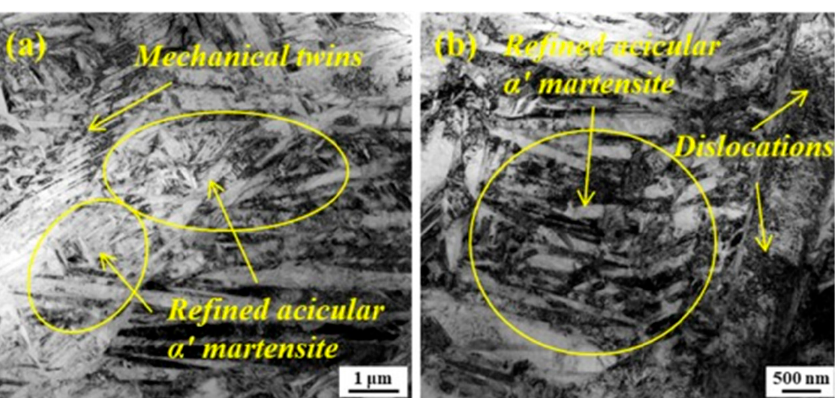
Figure 16. Typical TEM images of the LSP’ed SLM specimen. ( a ) Refined acicular martensite and MTs ( b ) dislocations and refined acicular martensite. Reproduced with permission from [120]. Copyright Elsevier, 2021.